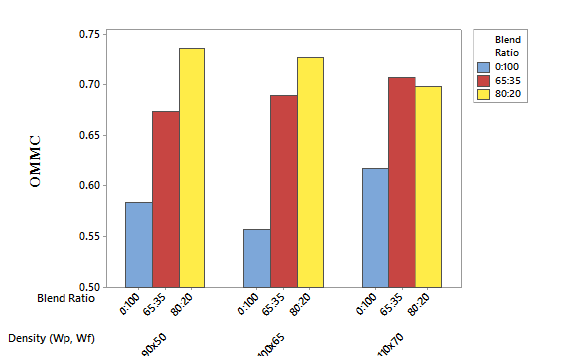
Fig. 2: Overall Moisture Management Capability (Ommc) Values of Developed Samples In equation (3), C 1 = 0.25, C 2 = 0.5 and C 3 = 0.25. The higher output of equation (3) will show that a fabric has excellent moisture management properties [17].